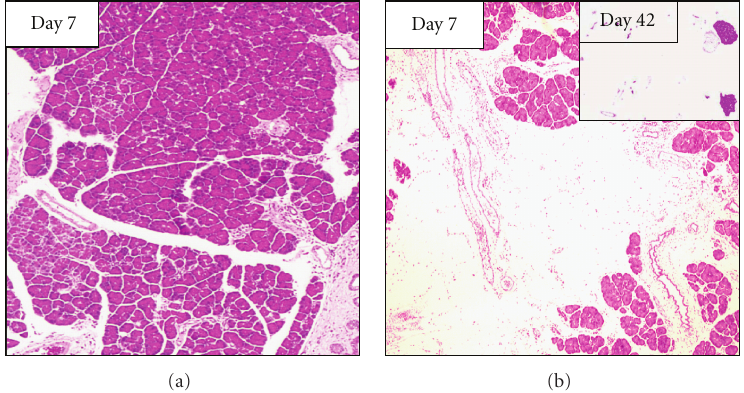
Figure 1: Representative photomicrographs of the pancreas after intraperitoneal (ip) injection of 20 μ g/kg body weight of Cn (a) or 500mg/100 g body weight of arginine (b). (a) Seven days after the last Cn injection (on day 35 after the first Cn injection), the pancreas was recovered and histologically normal. (b) On day 28 after the last ip injection of arginine (on day 40 after the first arginine injection), acinar architecture was destroyed with focal acinar cell necrosis. Inset: on day 42 after the last ip injection of arginine (on day 54 after the first arginine injection), acinar tissues were replaced by fatty tissue. (Hematoxylin and eosin staining, original magnification ×